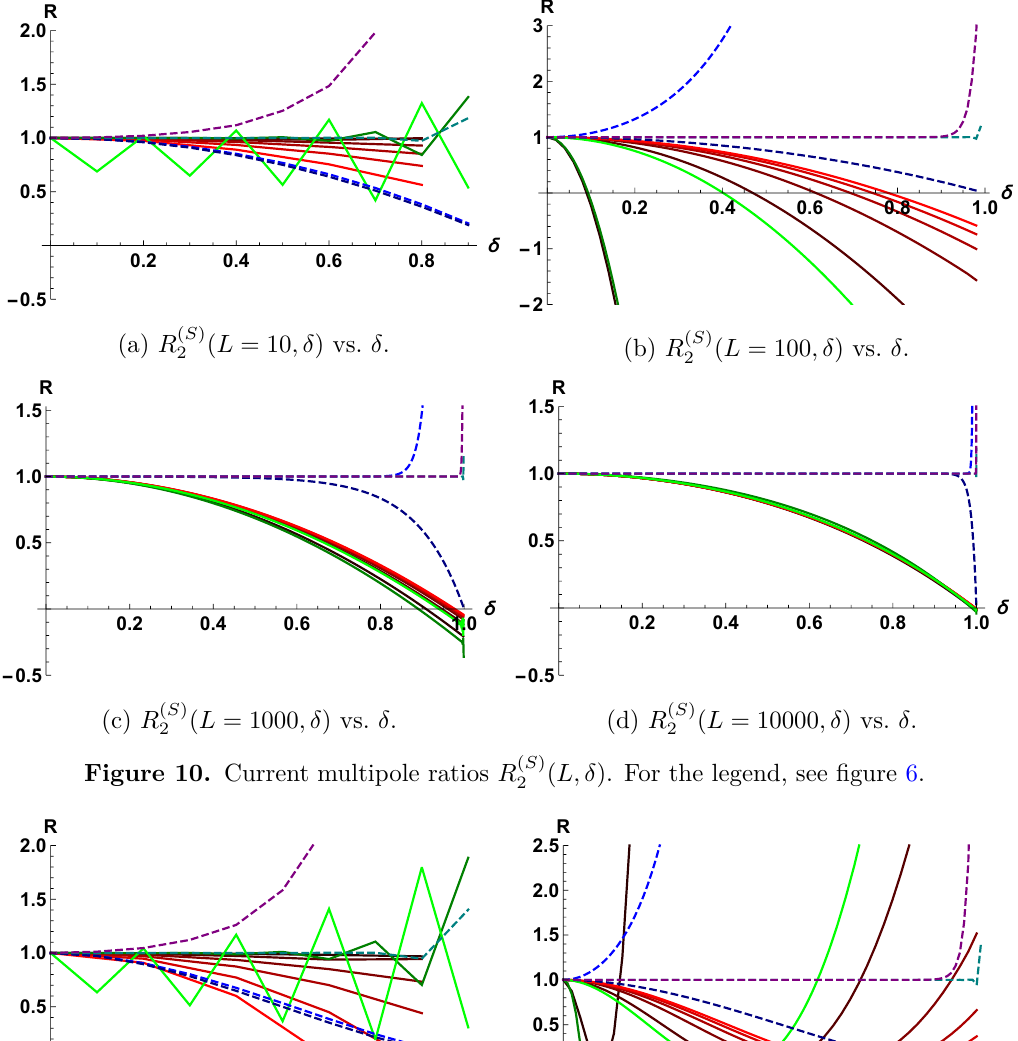
( L, δ ) . For the legend, see figure 6. 2